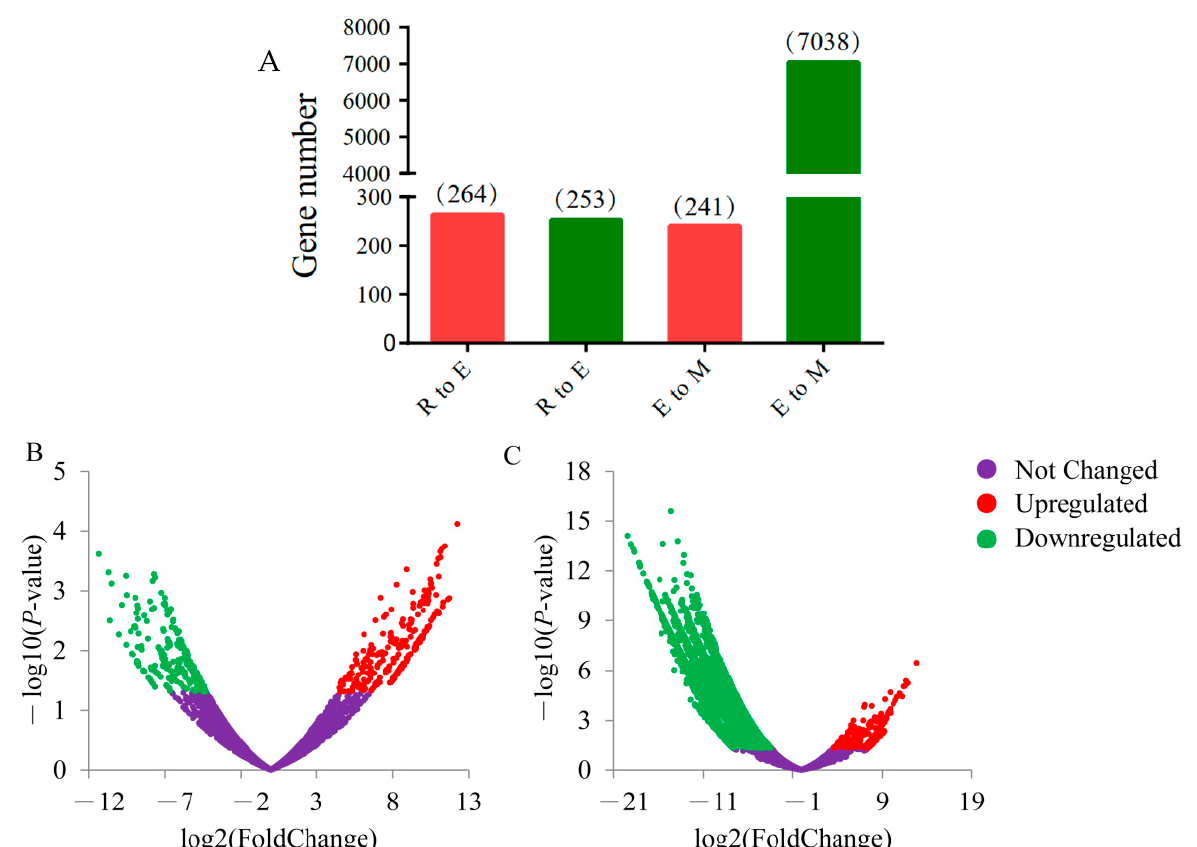
Figure 4. Differentially expressed genes (DEGs) at each deformation stage in bovine sperm. ( A ) Histogram of upregulated and downregulated genes during spermiogenesis. The abscissa R to E represents the stage of round to elongated spermatid, E to M represents the stage of elongated spermatid to epididymal sperm, and the ordinate represents the number of DEGs. ( B , C ) DEG volcano diagrams from round spermatid to elongated spermatid and from elongated spermatid to epididymal sperm, respectively. The abscissa represents the differential multiple of genes, whereas the ordinate represents the significance of the difference. p -value < 0.05 and |log2 (fold change)| ≥ 1 are used as the screening criteria for DEGs. Red indicates upregulated DEGs, green indicates downregulated DEGs, and purple indicates no significant changes in relative gene ex- pression.